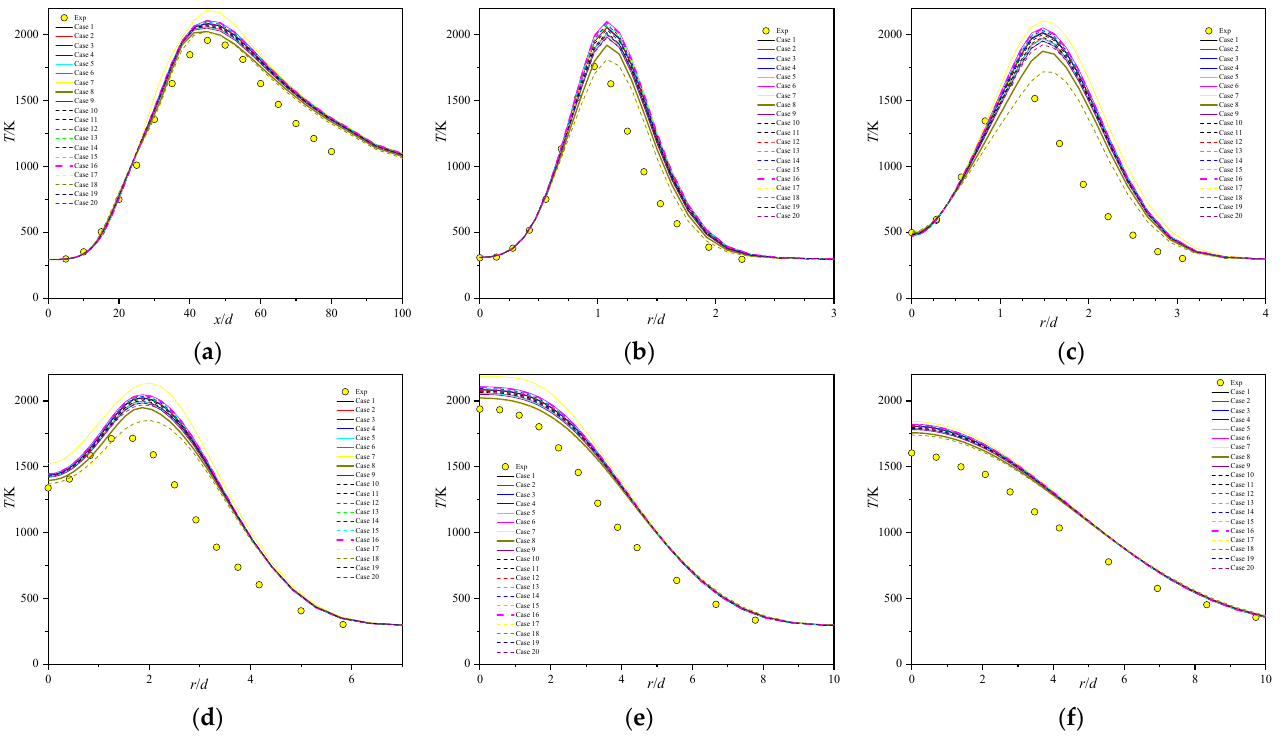
Figure 5. Comparison of measured [22,24] and predicted mean temperature profiles for the Sandia Flame D with 20 combinations of the primary EDC constants C D1 and C D2 . ( a ) @axis. ( b ) @ x / d = 7.5. ( c ) @ x / d = 15. ( d ) @ x / d = 30. ( e ) @ x / d = 45. ( f ) @ x / d = 60.